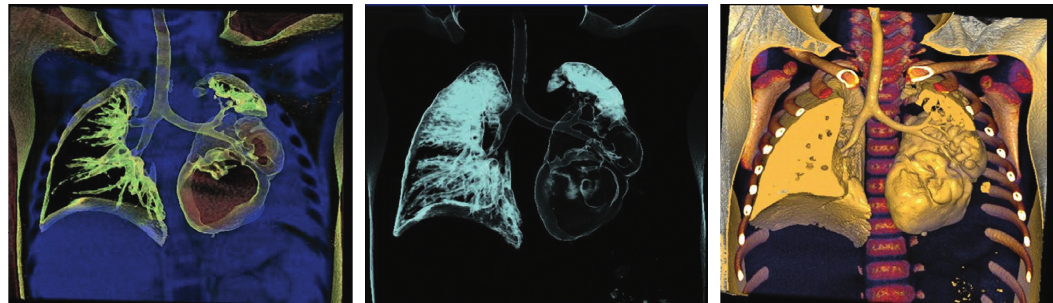
Figure 7: Noncontrast frontal view chest CT, image reformatting volume rendered display: coronal reformation in standard lung window to allow three-dimensional view. Pneumatoceles, thin-walled cavities developing secondary to